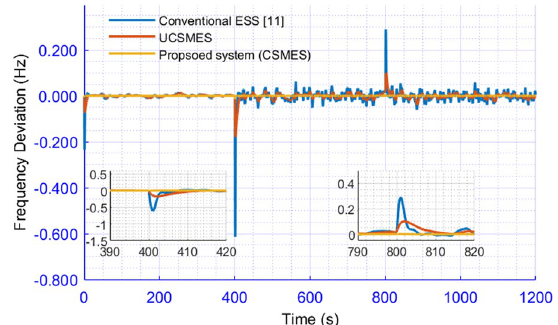
Fig. 9 Frequency deviation of the considered system for scenario A at 50% system inertia